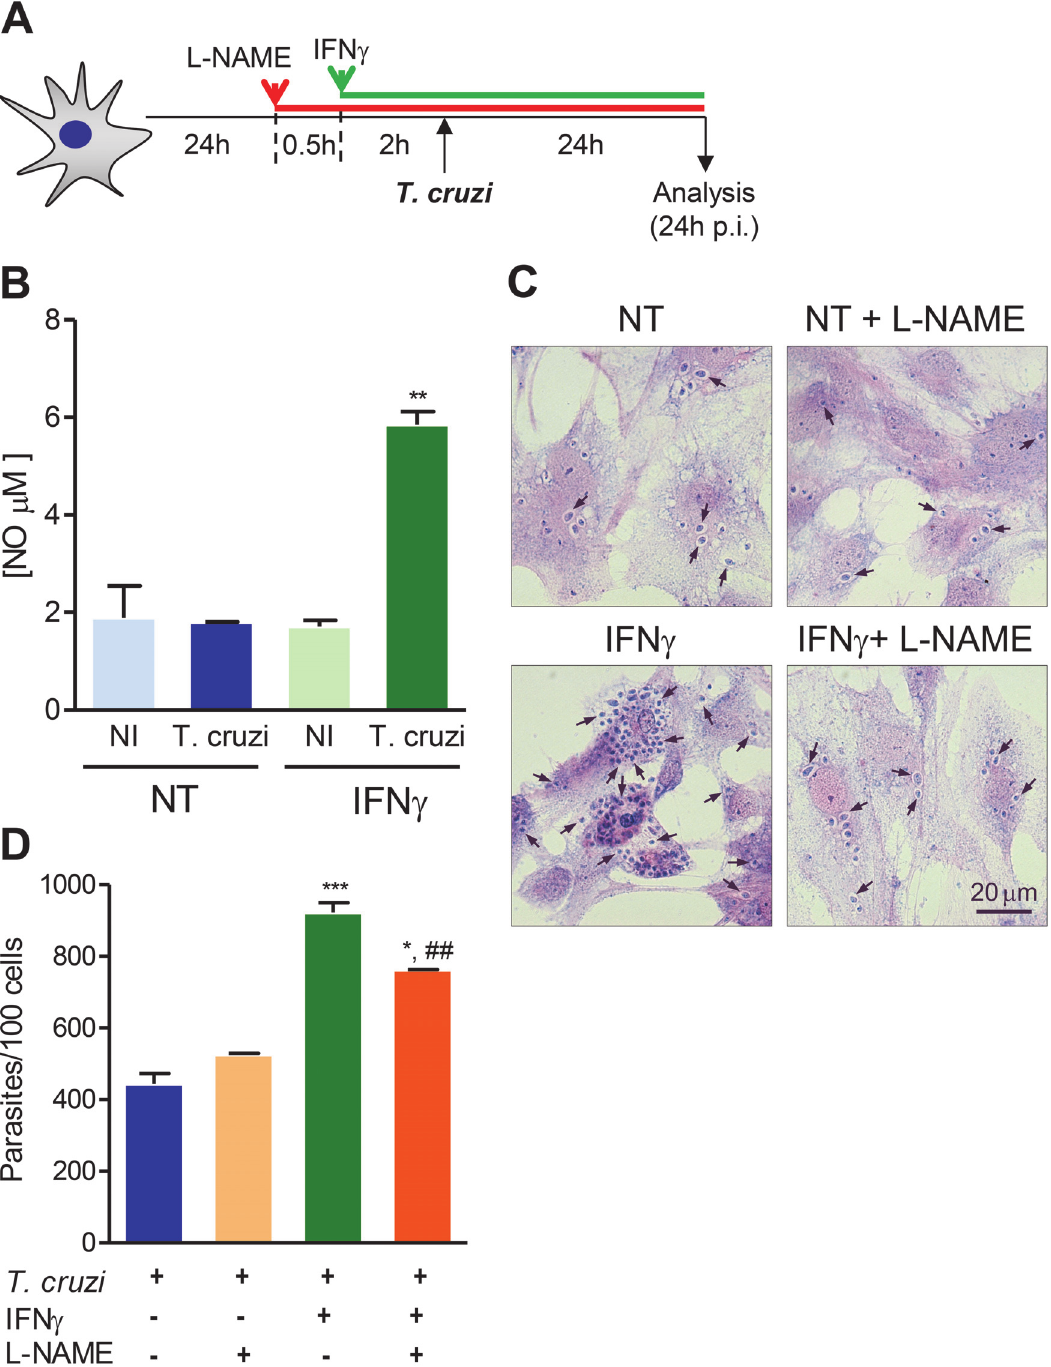
Fig 5. Two signals are required for nitric oxide production by T. cruzi -infected astrocytes. (A) Primary astrocyte cell cultures were pretreated or not with IFN γ (10 ng/mL) in the absence or presence of L-NAME, infected using MOI 10:1 and analyzed 24 hours post-infection (p.i.). (B) The graph shows NO production by astrocytes treated or not (NT) with IFN γ and infected or not (NI) with T. cruzi . (C) Representative pictures of IFN γ - pretreated astrocytes infected in the absence or presence of L-NAME. (D) The graph shows the number of intracellular forms of the parasite per 100 cells in the different experimental conditions. Data are presented as mean ± SEM of triplicates. * , p < 0.05, ** , p < 0.01 and *** , p < 0.001 comparing IFN γ pretreated astrocytes with NT cells; ## , p < 0.01 comparing IFN γ pretreated astrocytes in absence or presence of L-NAME.